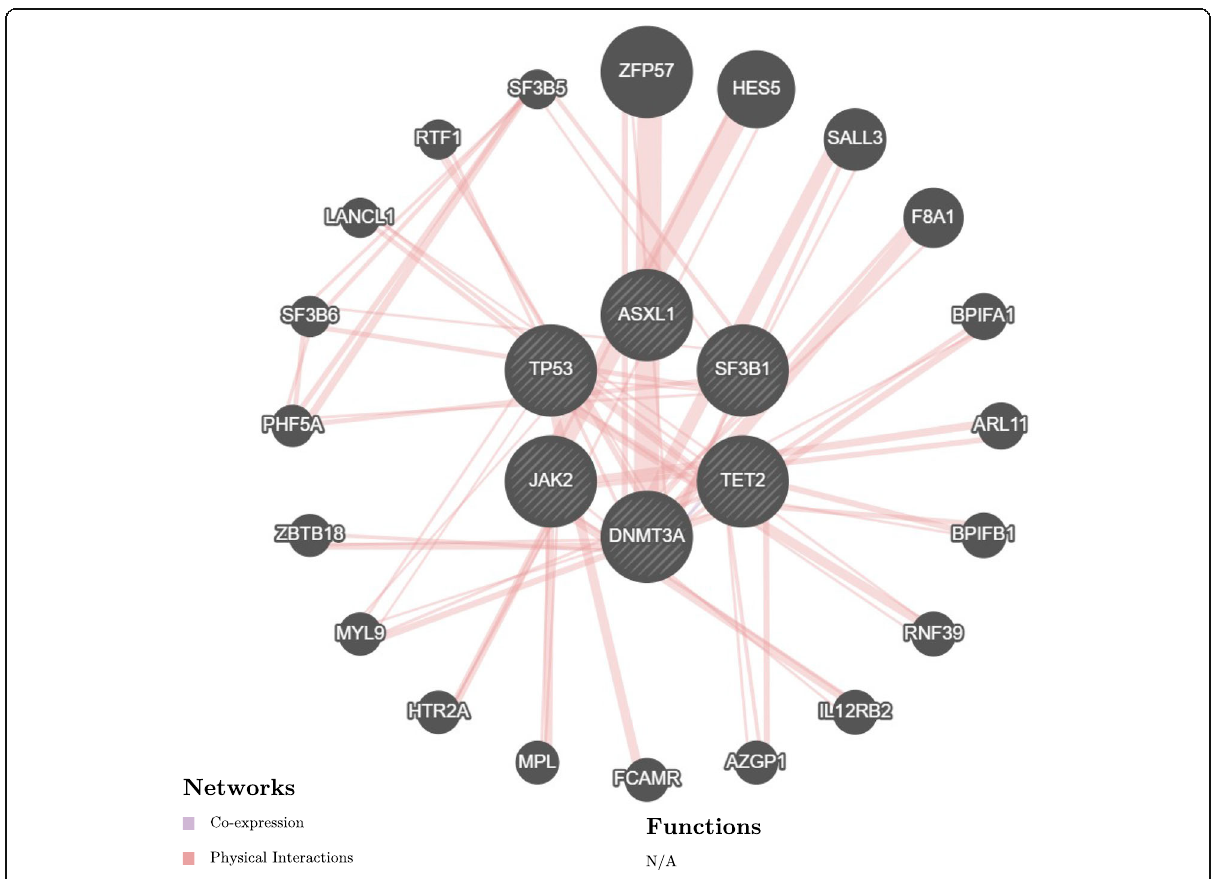
Fig. 2 Network analysis of the DNMT3A , TET2 , ASXL1 , TP53 , JAK2 , and SF3B1 genes using